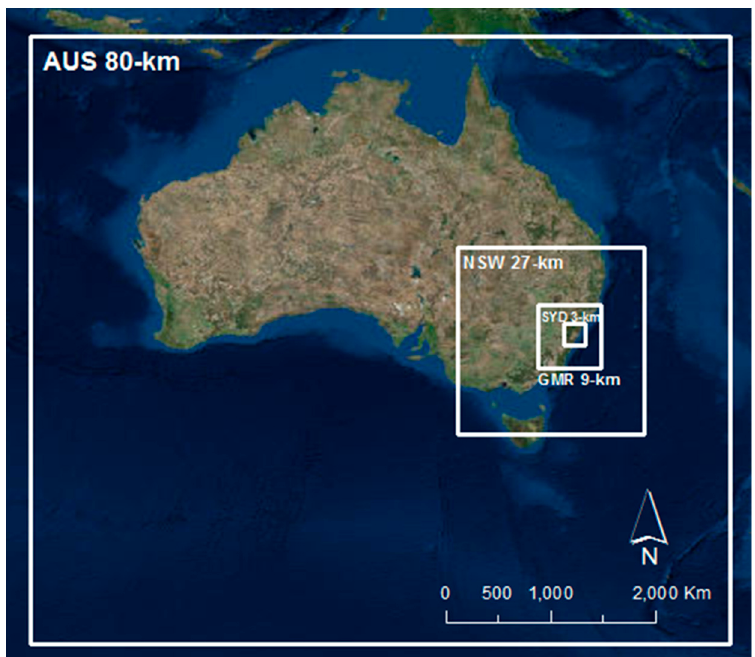
Figure 2. Domain configuration of the CCAM-CTM modelling system. The four nested domains are with a horizontal resolution of 80-km (AUS), 27-km (NSW), 9-km (GMR) and 3-km (SYD), respectively.